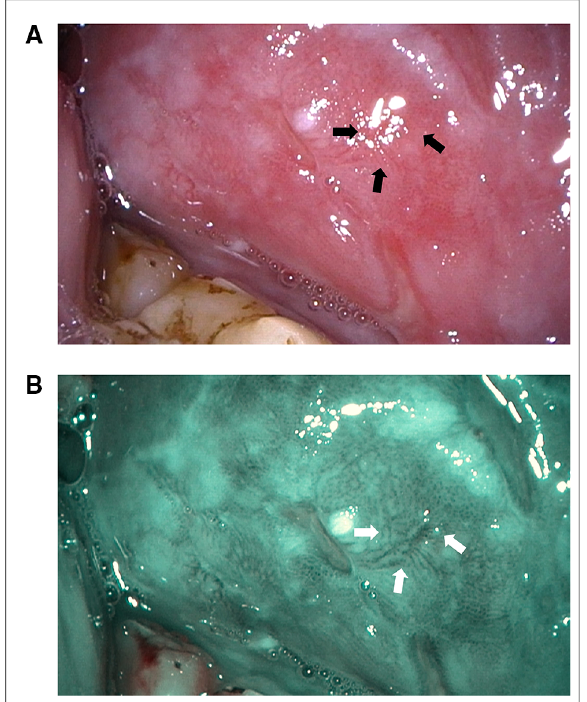
FIGURE 1 White light ( A ) narrow band ( B ) images of the OPMD lesions which was fi nally diagnosed as moderate epithelial dysplasia on the left buccal mucosa of one elderly male patient in our clinic. White and black arrows showed the vessels pattern presenting as IPCL III. OPMD, oral potentially malignant disorders; IPCL, intra-epithelial papillary capillary